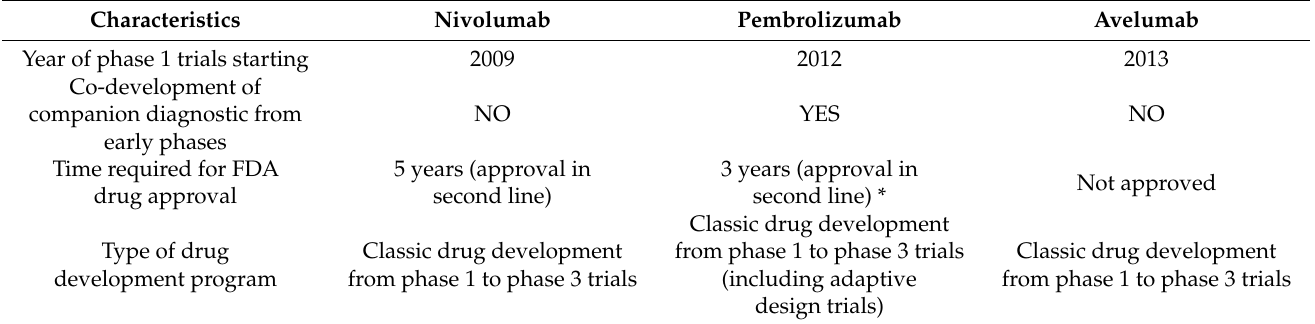
Table 2. Differences in immune checkpoint inhibitors development